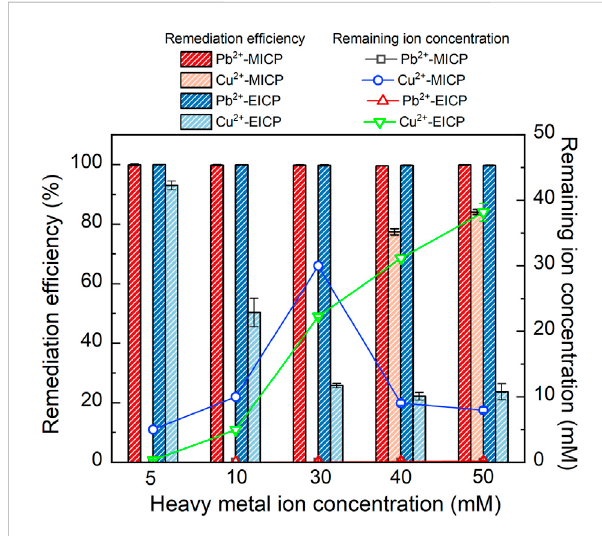
FIGURE 5 Relationships of remediation ef fi ciency and remaining Pb 2+ or Cu 2+ concentration versus Pb 2+ or Cu 2+ concentration under MICP and EICP